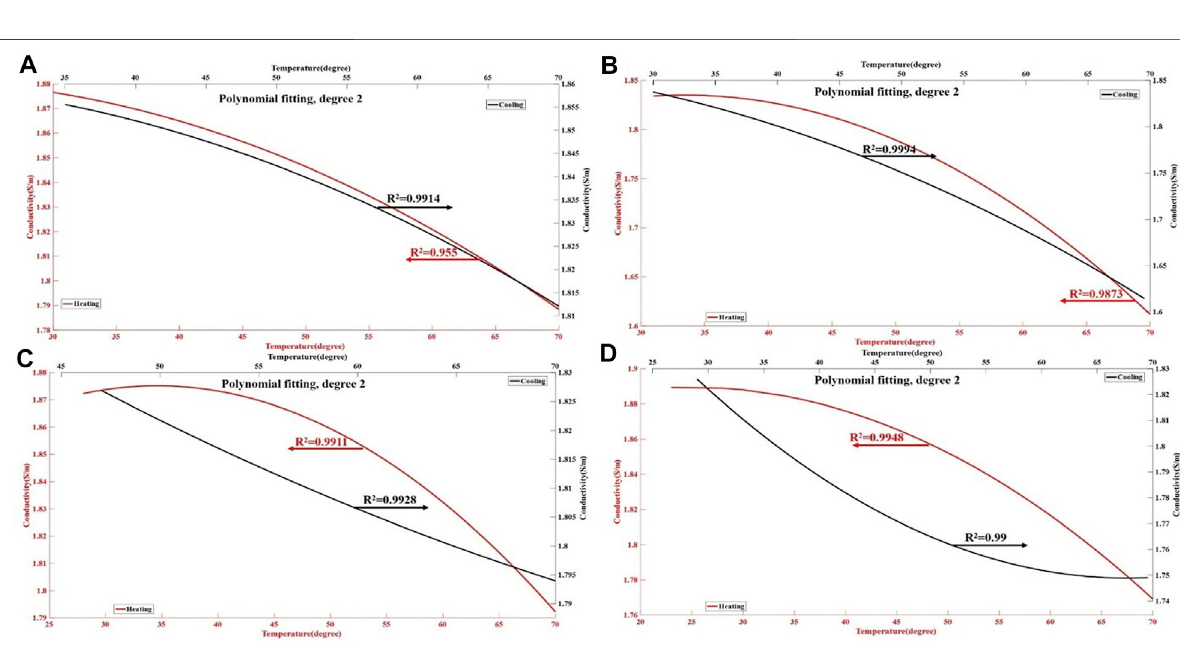
Frontiers in Physics |